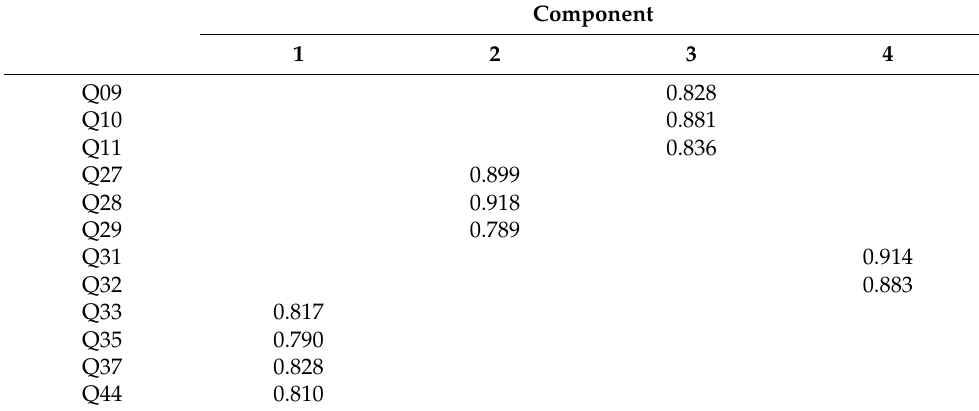
Table 4. Rotated component